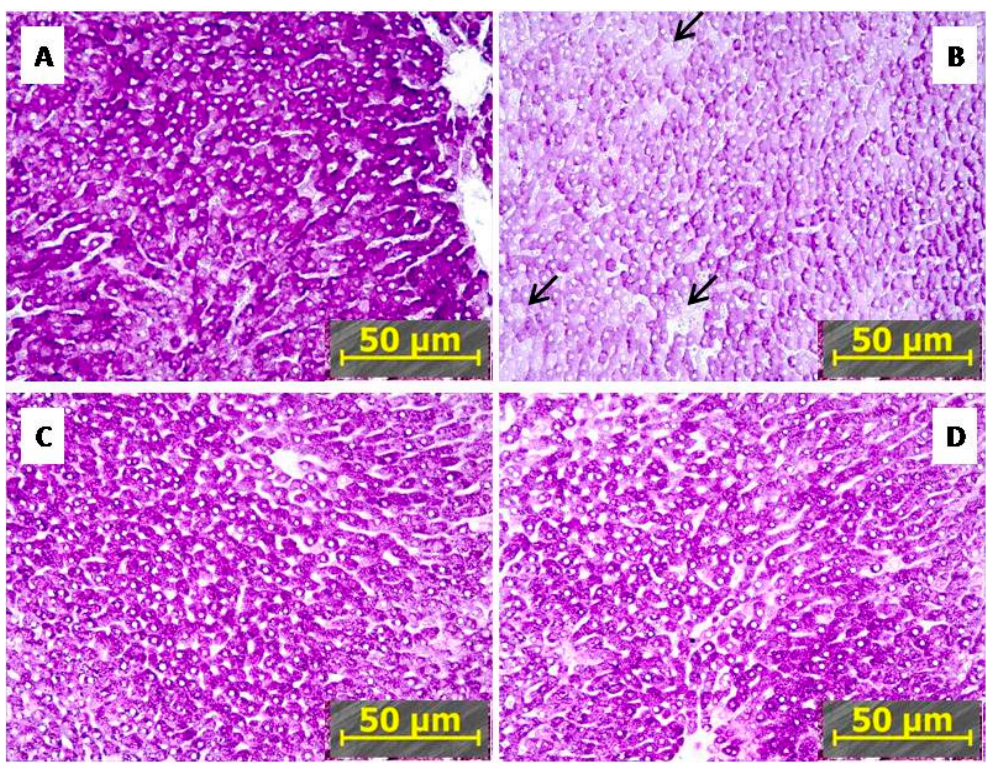
Figure 5. Representative microscopy of glycogen in the rat liver (Chic reaction). ( A ) control, ( B ) PTSD; ( C ) IHC, ( D ) PTSD+IHC. Arrows indicate cells deprived of glycogen. Magnification ×200.